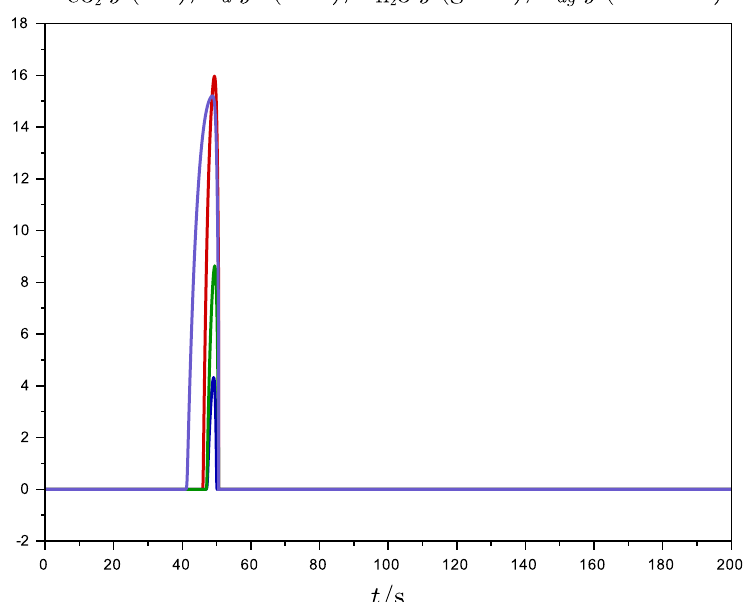
Figure 14. Logarithmic plot of the rates (in units 10 − 16 s − 1 ) for decarboxylation, dimerization, dehydration, and degassing of glycine in a micrometeorite with v 0 = 3.7 km s − 1 , R 0 = 70 µ m, and θ 0 = 45.0 deg.